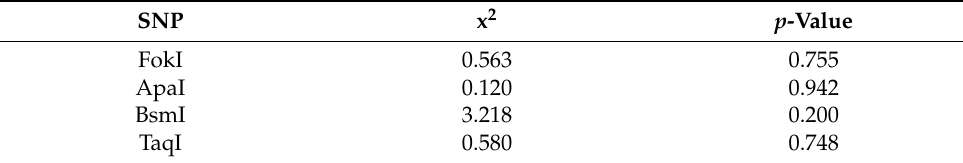
Table 4. Hardy–Weinberg equilibrium for the control